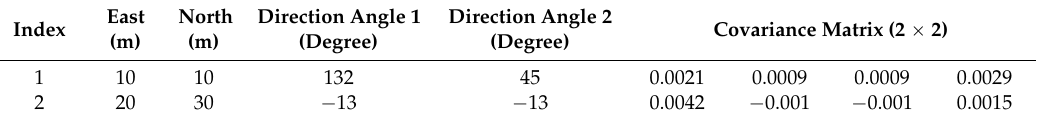
Figure 10. Extraction result of the two nearest corners. Table 1. An example of a corner map.